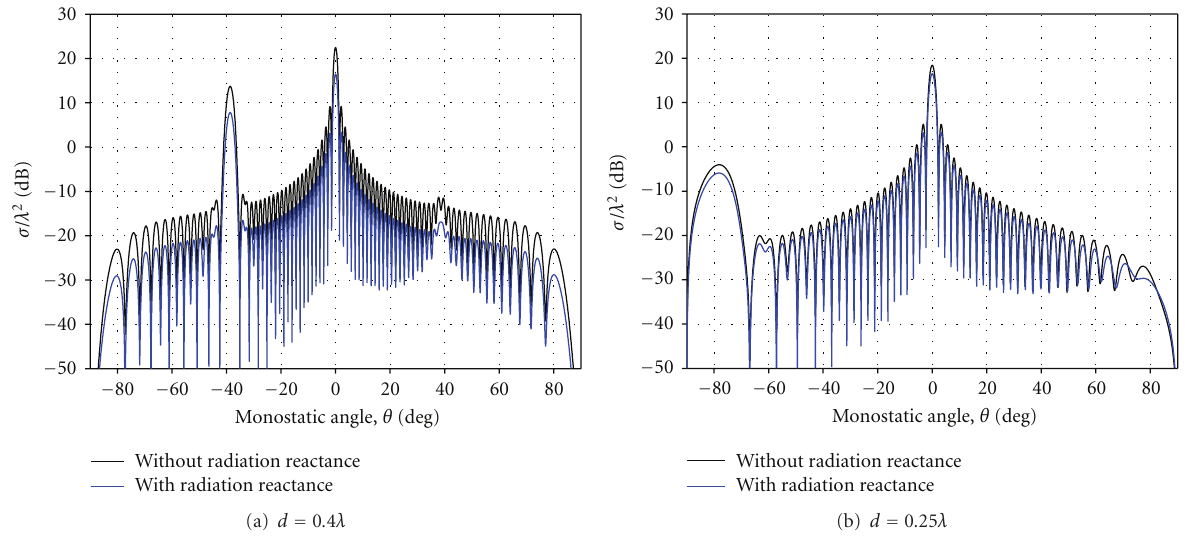
Figure 14: RCS of series-fed linear array. N = 50, θ s = 0 ◦ , ψ = π/ 2, l = 0 . 488 λ and r r = r p = r c = r l = 0 . 2; uniform unit amplitude distribution.